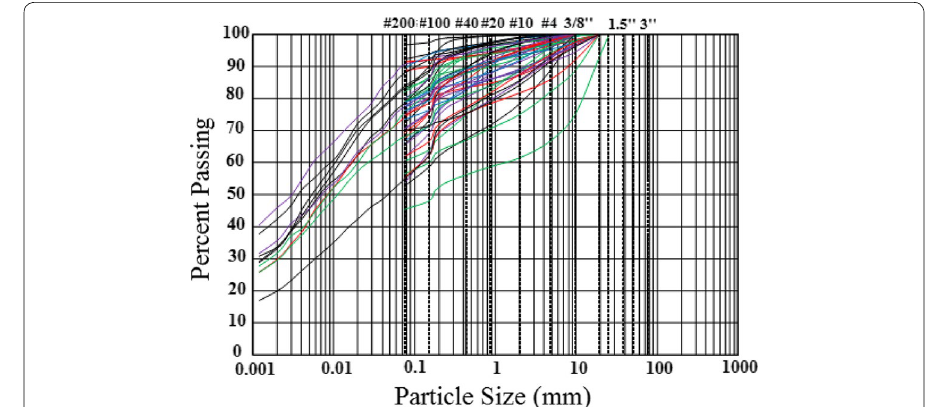
Fig. 17 Grain size distribution test results for a site located in district 18,